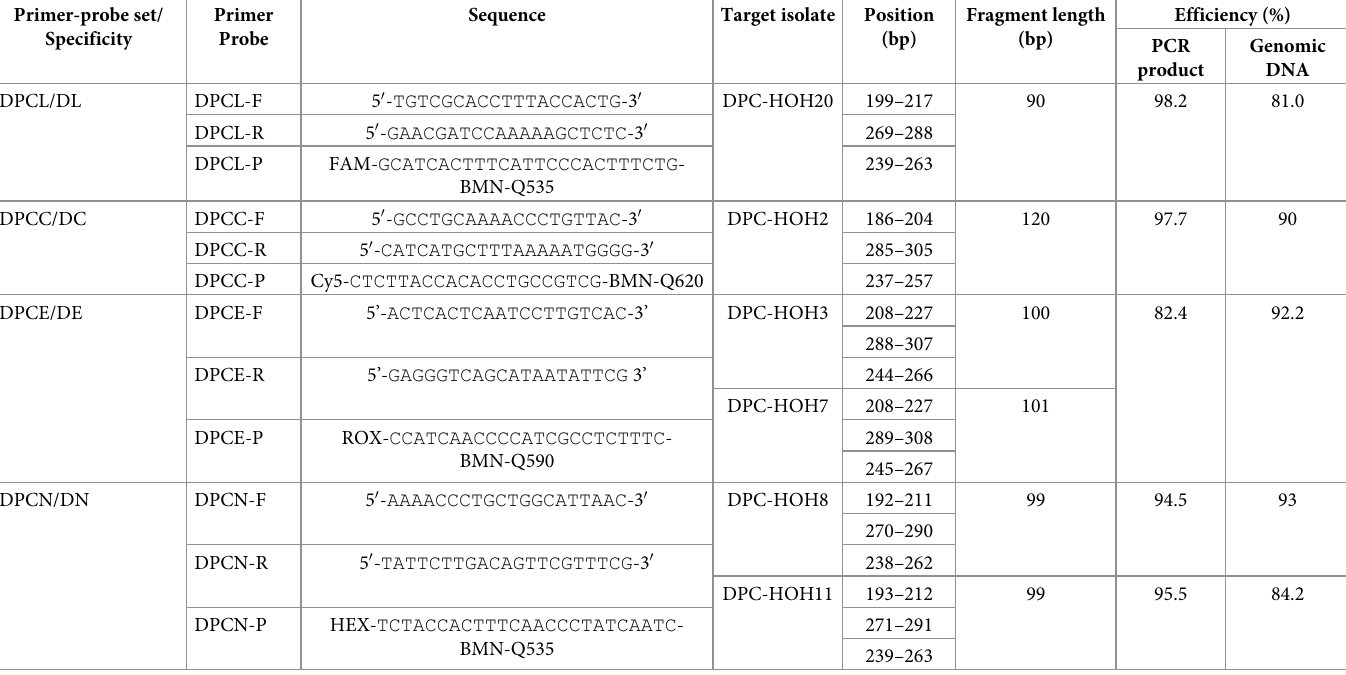
Table 2. TaqMan primer-probe combinations for detection and distinguishing D . longicolla , D . caulivora , D . eres and D . novem